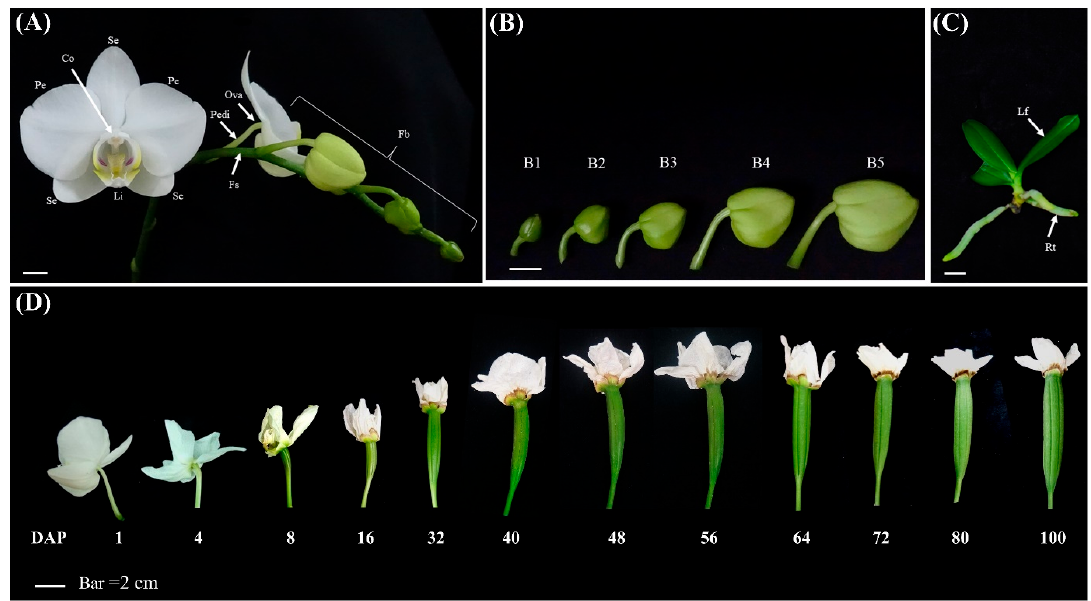
Figure 1. Morphology of Phalaenopsis aphrodite subsp. formosana. ( A ) Fully blooming flowers with floral buds and floral stalks in Phalaenopsis orchids. Scale bar = 1 cm. ( B ) Flower buds. Scale bar = 1 cm. ( C ) Leaf and root. Scale bar = 1 cm. ( D ) Developing ovary. Scale bar = 2 cm. Se, sepals; Pe, petals; Li, lip; Co, column (gynostemium); Pedi, pedicel; Fs, floral stalk; B1–B5, stage 1 to stage 5 floral